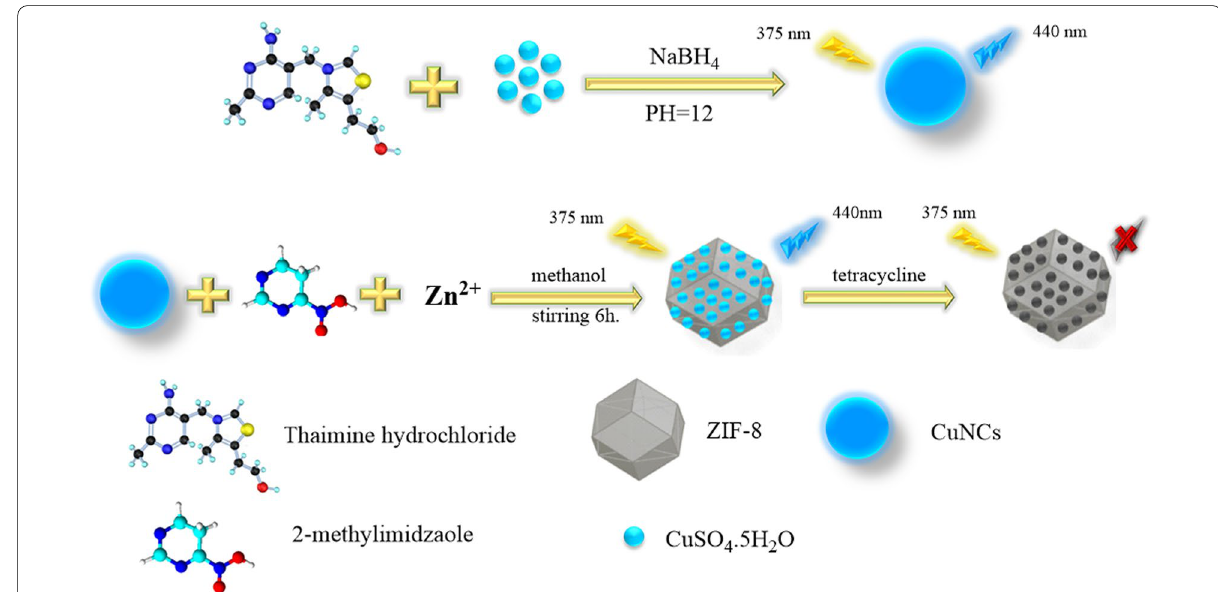
Fig. 1 Schematic presentation of preparation CuNCs@zif-8 for detection of